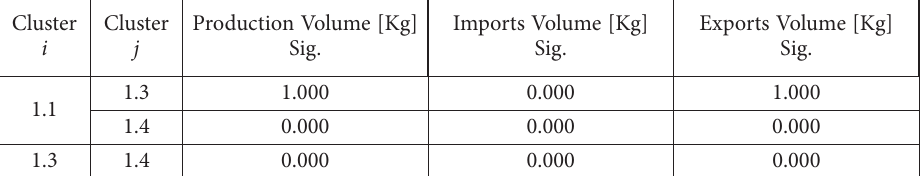
Table 11. Multiple comparisons (Bonferroni) at the second level of post-crisis clustering (source: own elaboration based on COMTRADE, 2018) Cluster Cluster i j